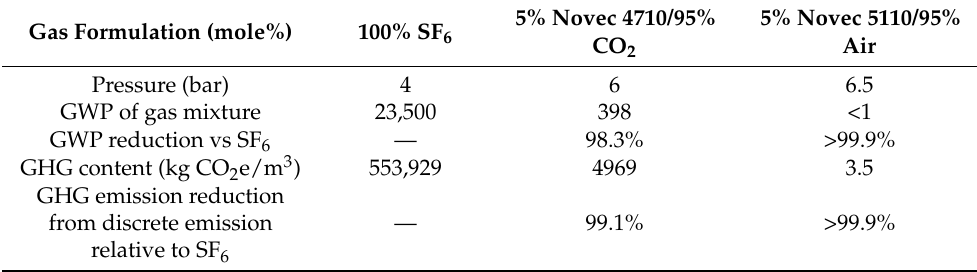
Table 4. Initial climate performance of alternative-gas mixtures compared to SF 6 . Gas Formulation